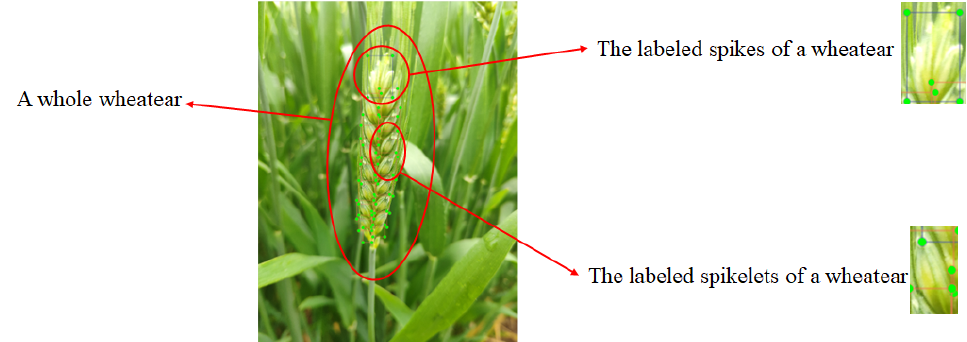
Figure 2. A labeled sample of the